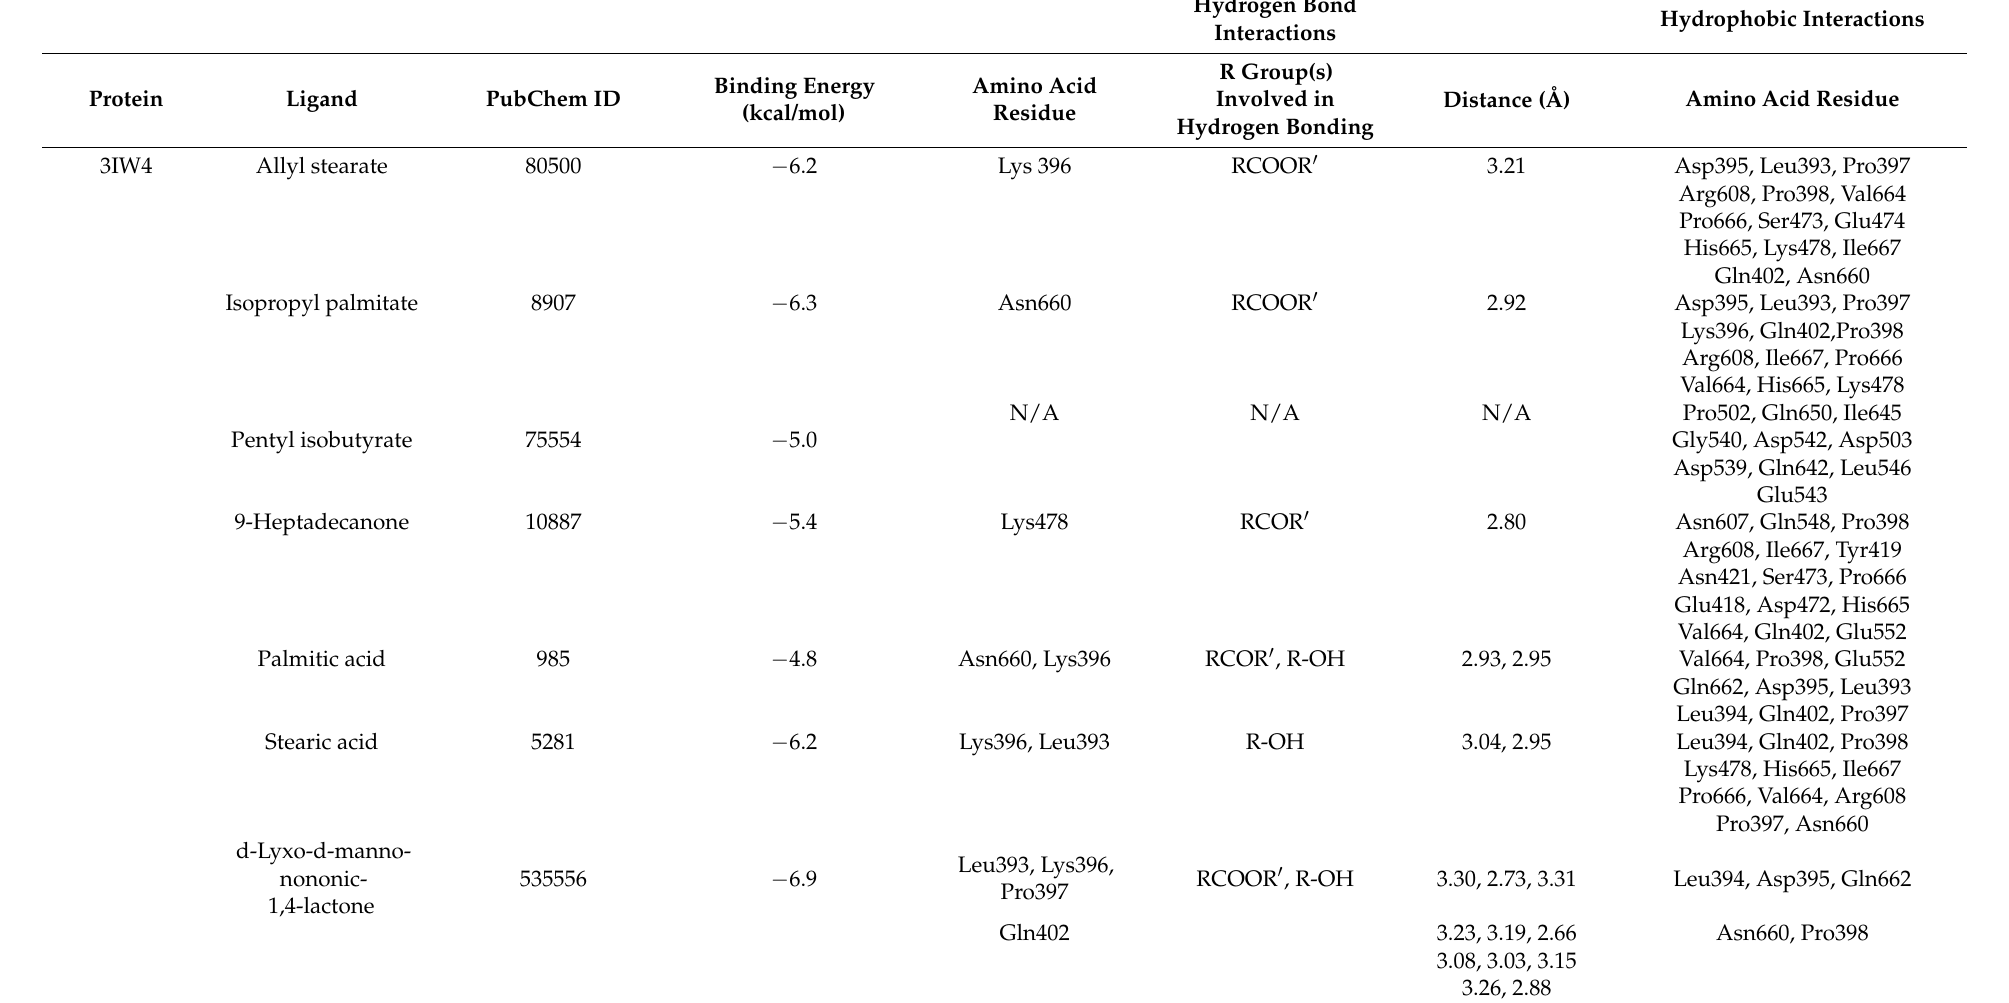
Table 8. Binding energy of potential bioactives on PRKCA (PDB ID: